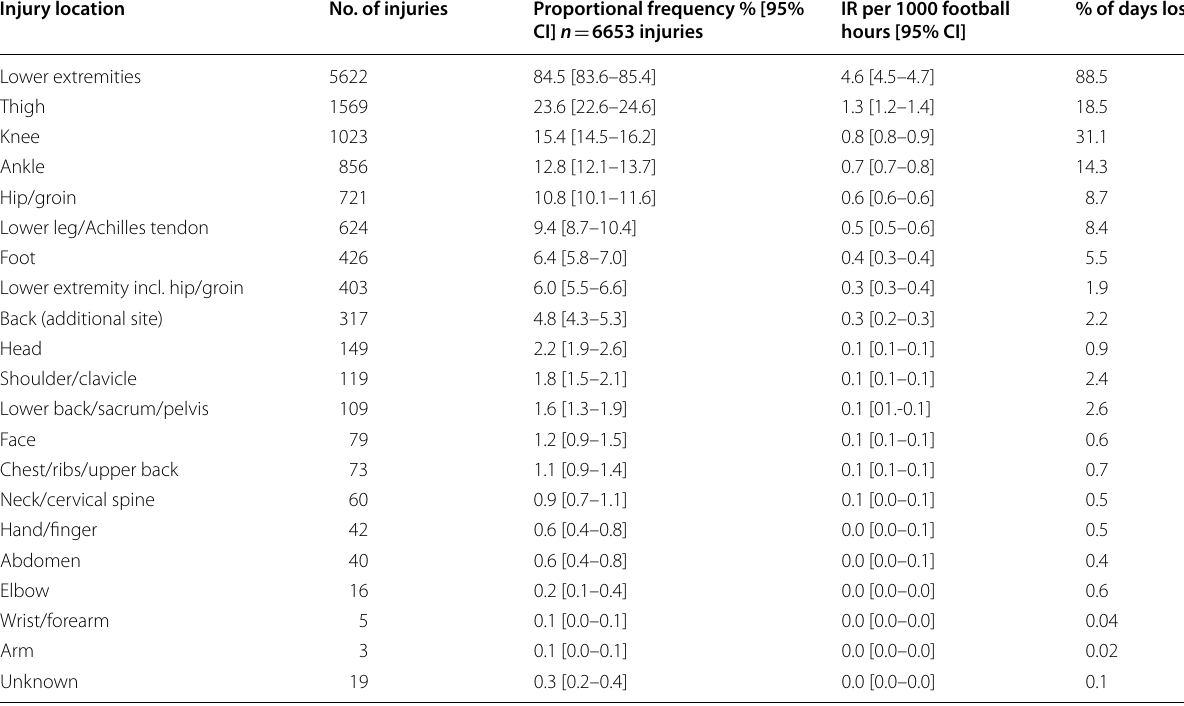
CI confidence interval; IR injury incidence rate